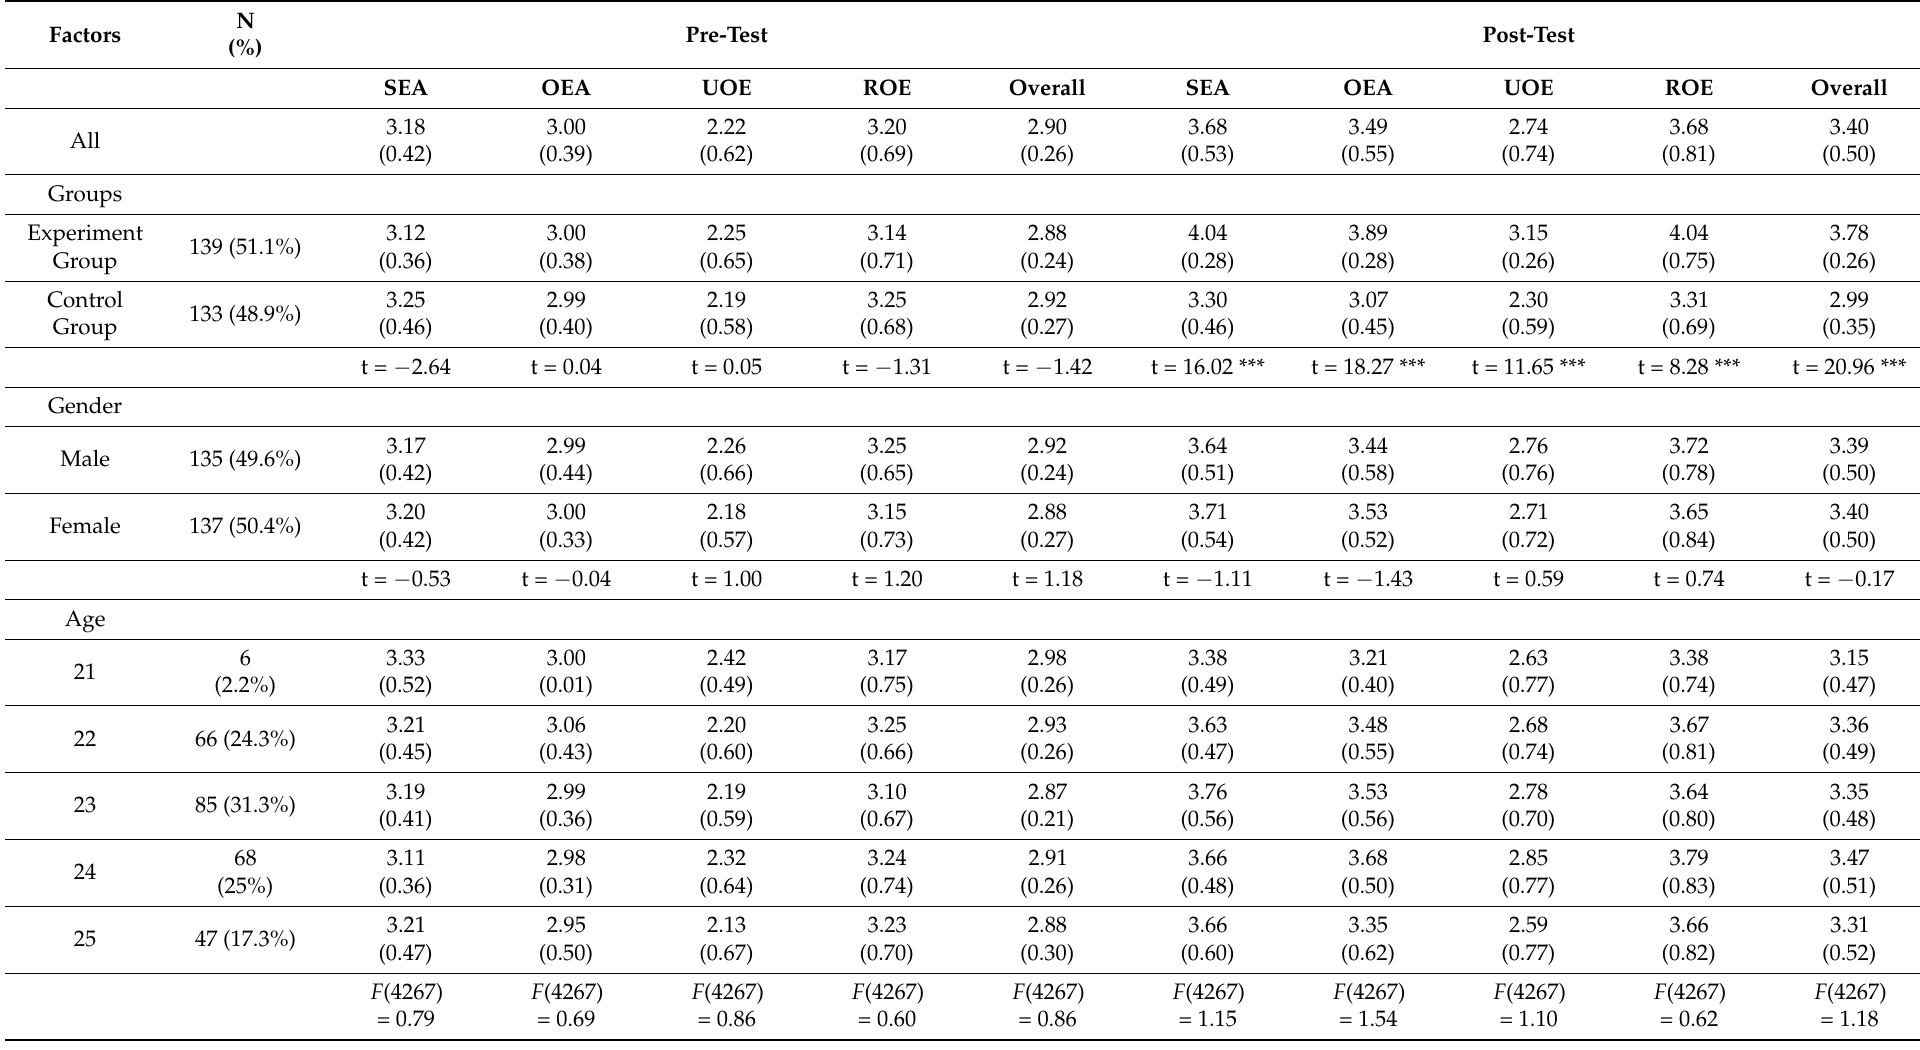
Table 1. Descriptive Statistics: Participants’ Demographics and their Relationship with Emotional Intelligence Scale